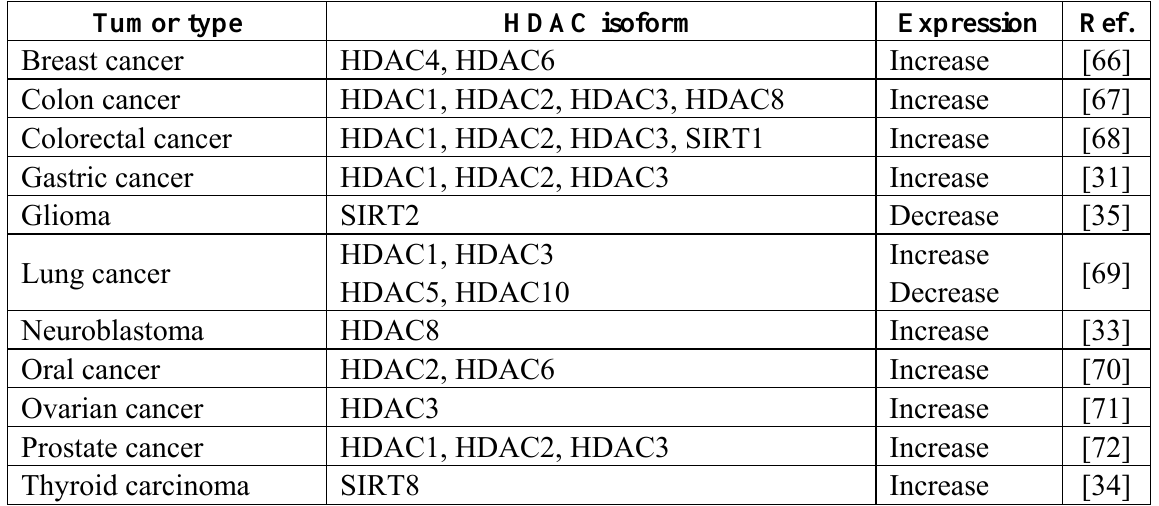
Table 1. HDAC expression in cancer.